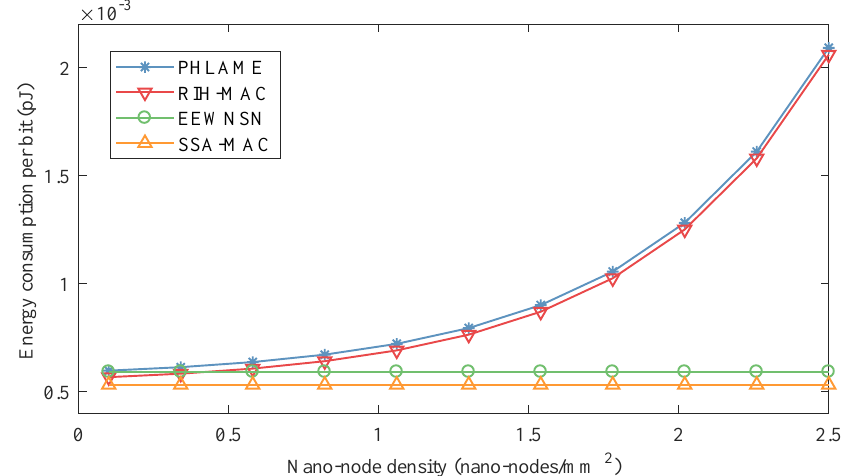
Figure 7. Energy consumption per bit of different MAC protocols as a function of nano-node density in centralized